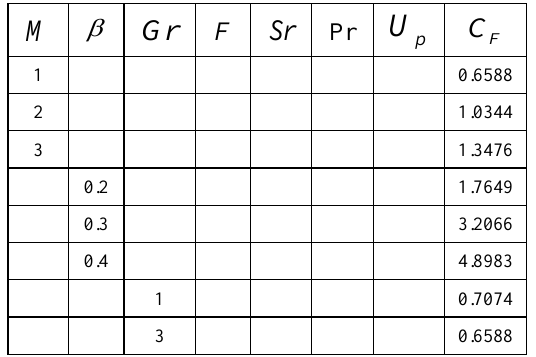
Table1. Effect of various physical parameters on Skin friction